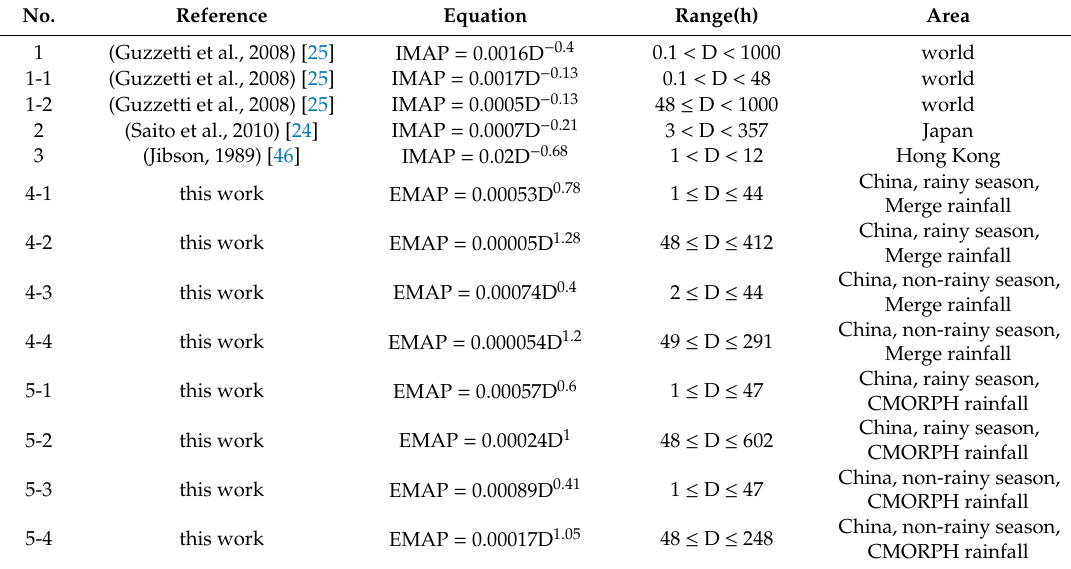
Table 5. EMAP–D rainfall thresholds for landslide occurrence in this study compared with those in previous